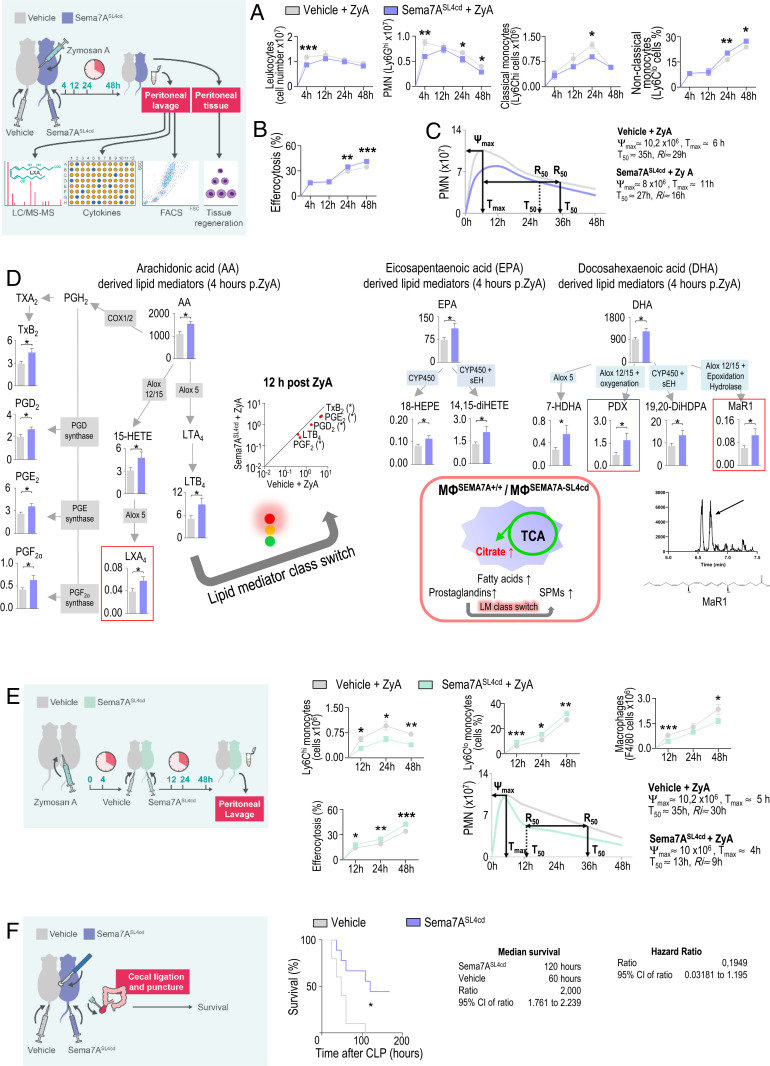
Exogenous Sema7A activates resolution programs. WT animals were sequentially injected with ZyA and vehicle or Sema7ASL4cd, and lavages were collected at 4, 12, 24, and 48 h. (A) Total leukocytes were counted by light microscopy, and PMNs and classical and nonclassical monocytes and (B) MΦ efferocytosis were assessed by flow cytometry (n = 6 to 17). (C) Resolution indices. (D) The levels of bioactive lipid mediators and precursors, including those in the AA, DHA, and EPA pathways, in the peritoneal fluids of WT animals that were treated with ZyA and Sema7ASL4cd or vehicle for 4 or 12 h (n = 9 to 19) were quantified by LC-MS/MS–based profiling. (E) WT animals were injected with ZyA and treated with vehicle or Sema7ASL4cd after 4 h at the peak of inflammation, and lavages were collected at 12, 24 and 48 h. Classical and nonclassical monocytes and MΦs as well as monocyte-derived macrophage efferocytosis were quantified by flow cytometry (n = 8 to 13). Resolution indices were determined. (F) The survival rates of WT animals treated daily with Sema7ASL4cd or vehicle that underwent the CLP procedure and the median survival (n = 9 to 10). The results represent three independent experiments and are expressed as the mean ± SEM (A–E); significance was determined by the unpaired two-tailed Student’s t test (A, B, D, and E), and the log-rank test (F), *P < 0.05, **P < 0.01, ***P < 0.001.